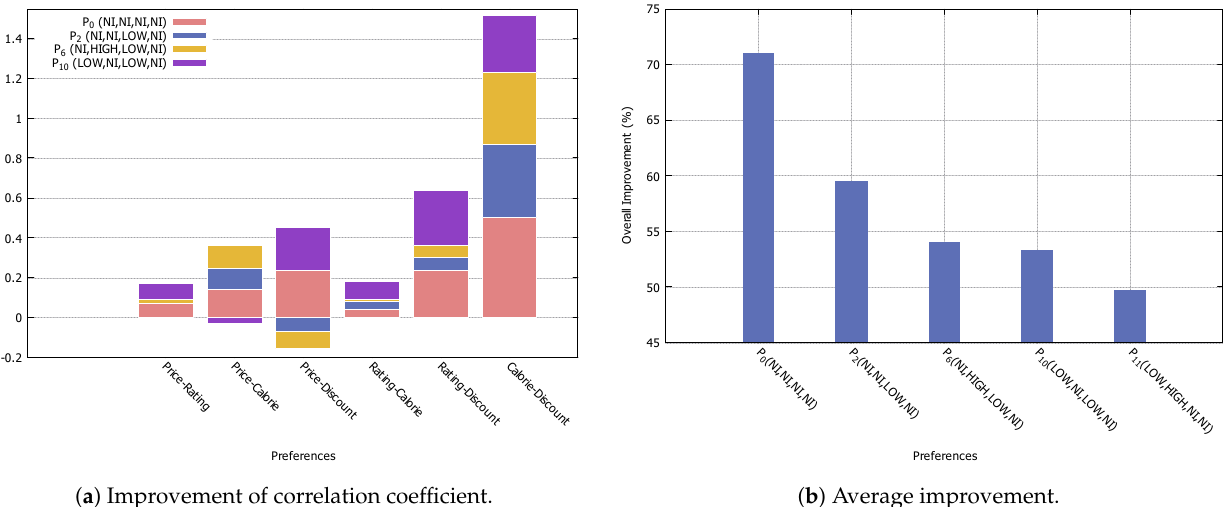
Figure 10. Improvement result. Calculated based on the correlation of implicit